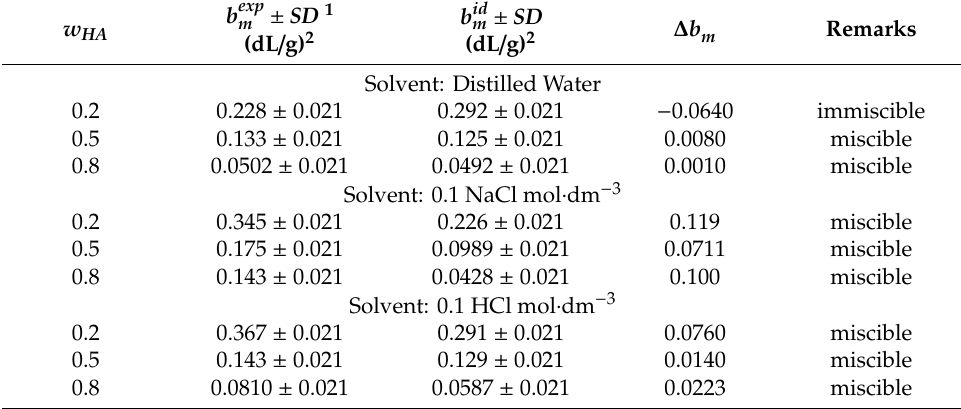
Figure 1. Reduced viscosity ( η sp / c ) values of hyaluronic acid (HA), poly(vinyl alcohol) (PVA) and their blends at 25 ◦ C: ( A ) distilled water; ( B ) 0.1 mol dm − 3 NaCl; ( C ) 0.1 mol dm − 3 HCl. Table 1. Experimental and ideal miscibility parameters b m of HA / PVA